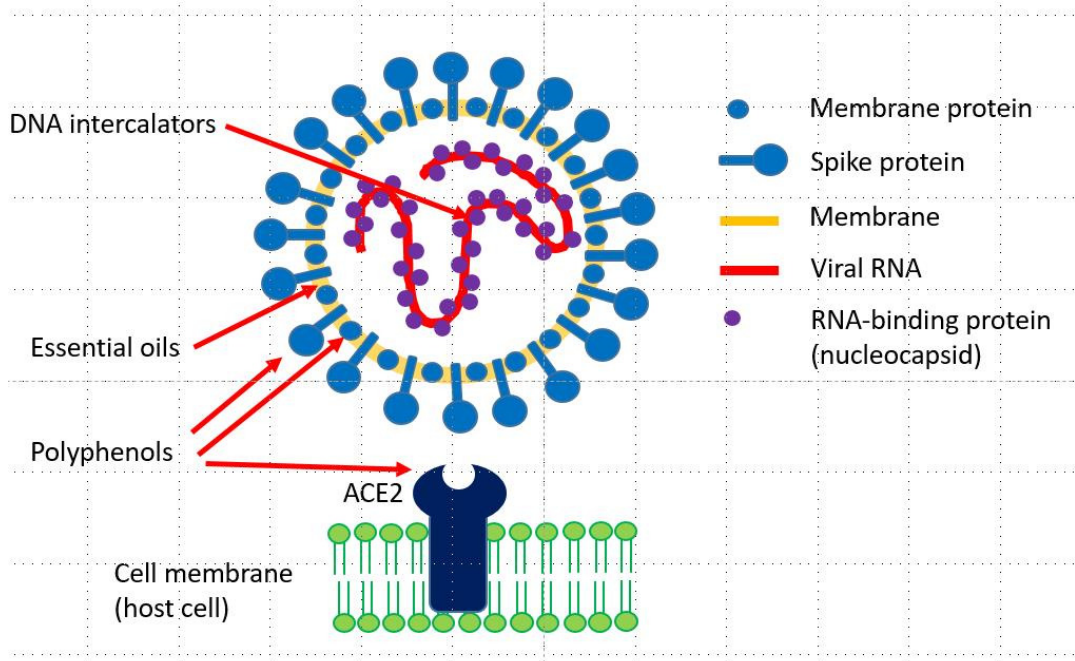
Figure 1. A simplified and schematic structure of severe acute respiratory syndrome coronavirus 2 (SARS-CoV-2), which can bind to a cellular receptor (ACE2) of a host cell with its spike proteins. Targets for antiviral drugs (essential oils, polyphenols and DNA intercalators) are indicated by red arrows.